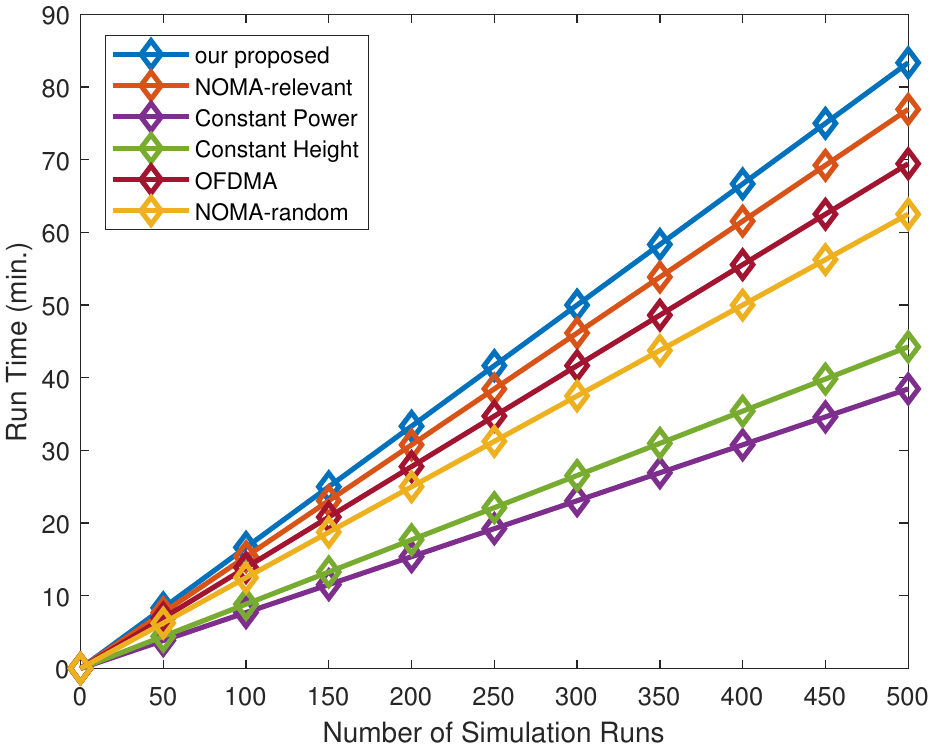
Figure 5. Simulation duration under different